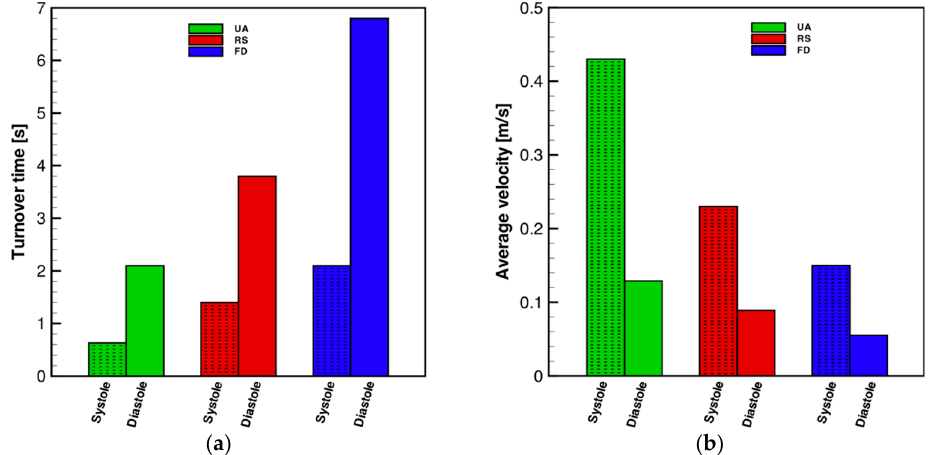
Figure 12. ( a ) Turnover time of the UA, RS, and FD at peak systole and late diastole and ( b ) average intra-aneurysmal velocity magnitude of the UA, RS, and FD at peak systole and late